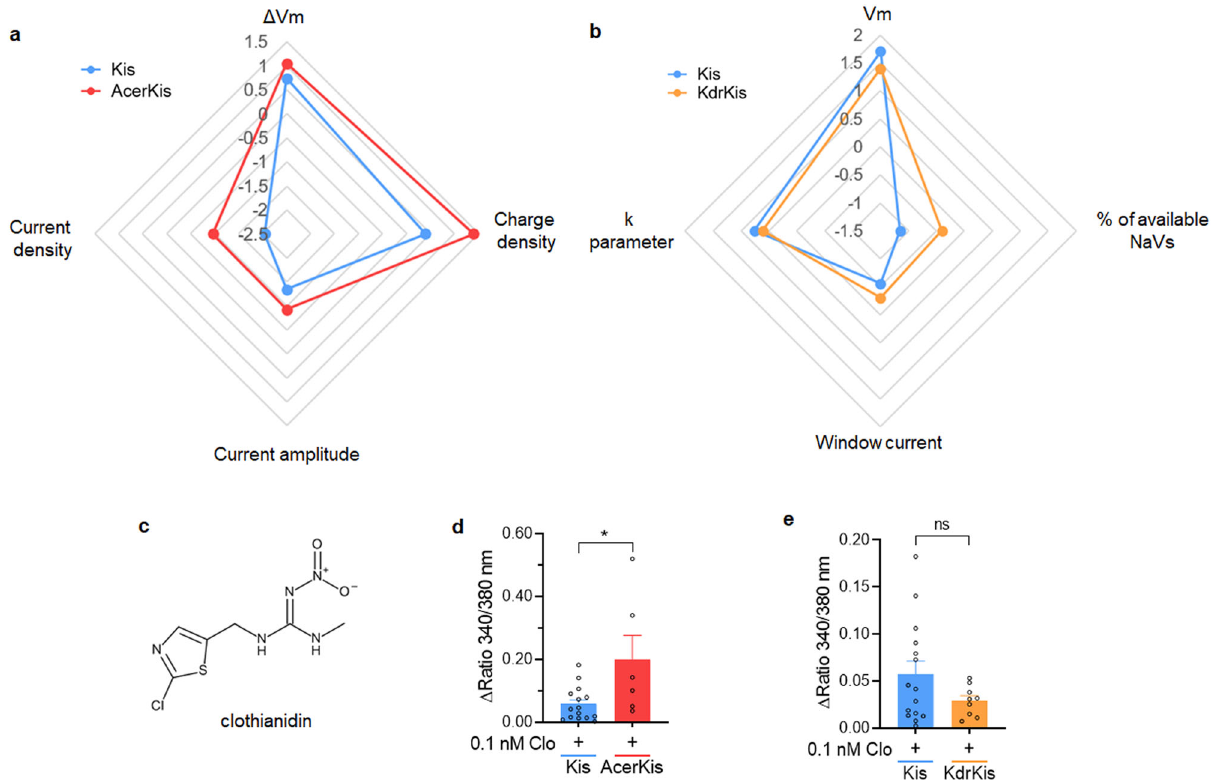
Fig. 9 Summary of the physiological parameters changes observed in neurons isolated from AcerKis and KdrKis strains and neonicotinoid insecticide clothianidin effectiveness in increasing neuronal [Ca 2 + ] i . a , b Radargraph comparing the changes (logarithmic scale) in the most important physiological parameters observed in Kis, AcerKis ( a ) and KdrKis ( b ) neurons. The effects of clothianidin ( c ) was studied in Fura2-loaded Kis, AcerKis and KdrKis neuron, using calcium imaging. d , e Comparative histogram illustrating the effects of clothianidin (0.1 nM) on the [Ca 2 + ] i recorded in AcerKis ( d ) and KdrKis ( e ) neurons compared to Kis neurons. Note that the [Ca 2 + ] i rise was greater in AcerKis than in KdrKis, indicating the key role of intracellular calcium level in the modulation of the nAChR sensitivity to clothianidin. Bars represent mean ± S.E.M. ( n = 15, n = 6 and n = 9 for Kis, AcerKis and KdrKis neurons, respectively). The statistical test used was Student unpaired t -test, * p < 0.05, ns, non-signi fi cant. The number of experiments ( n ) are biologically independent samples. Table Larval susceptibility of Anopheles gambiae Kis, AcerKis and KdrKis to clothianidin. Mosquito